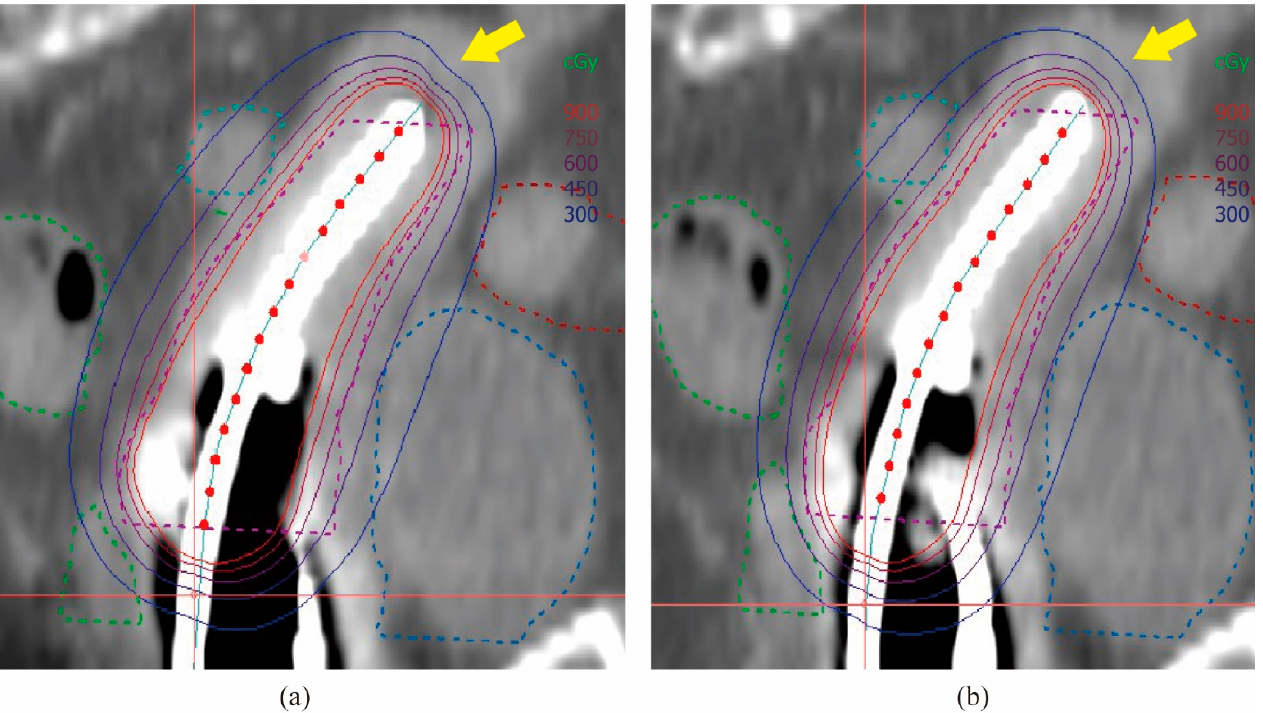
Figure 5. (3D HDR ICBT) Isodose line distribution in the sagittal plane of the transseptal canal. ( a ) 192Ir; ( b ) 60Co. As indicated by the arrows, 60Co was more prominently distributed in the cephalocaudal direction.